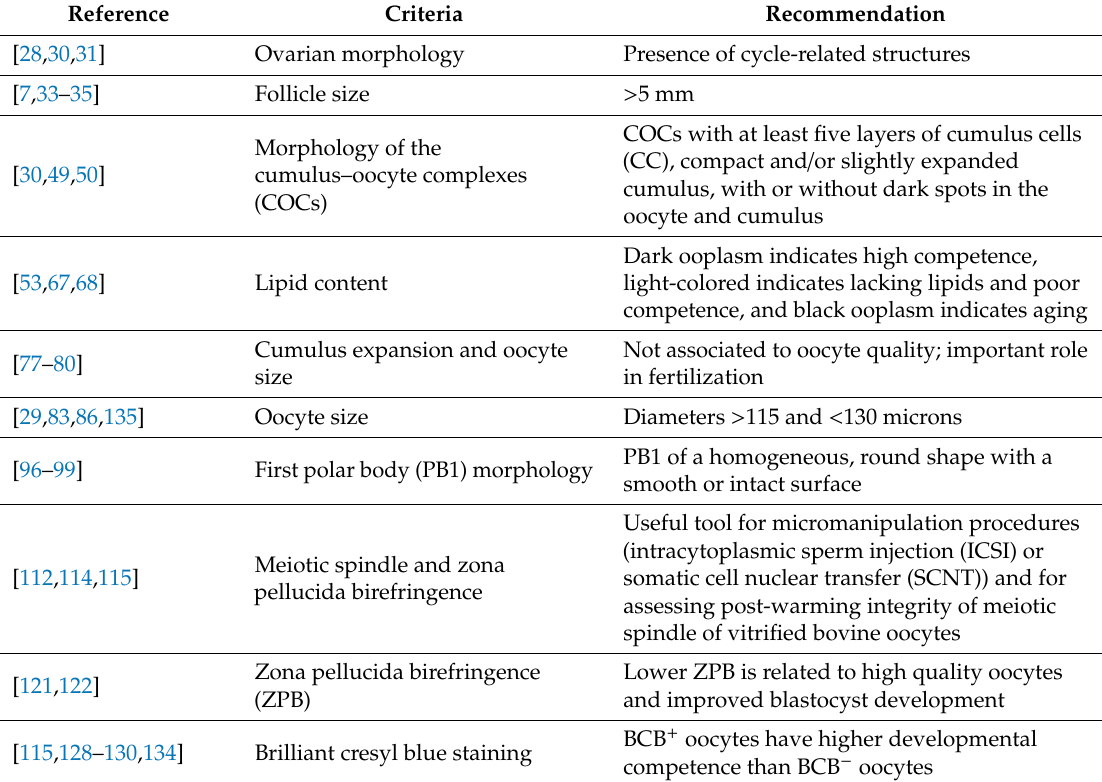
Table 1. Summary of the morphological and visual indicators of oocyte